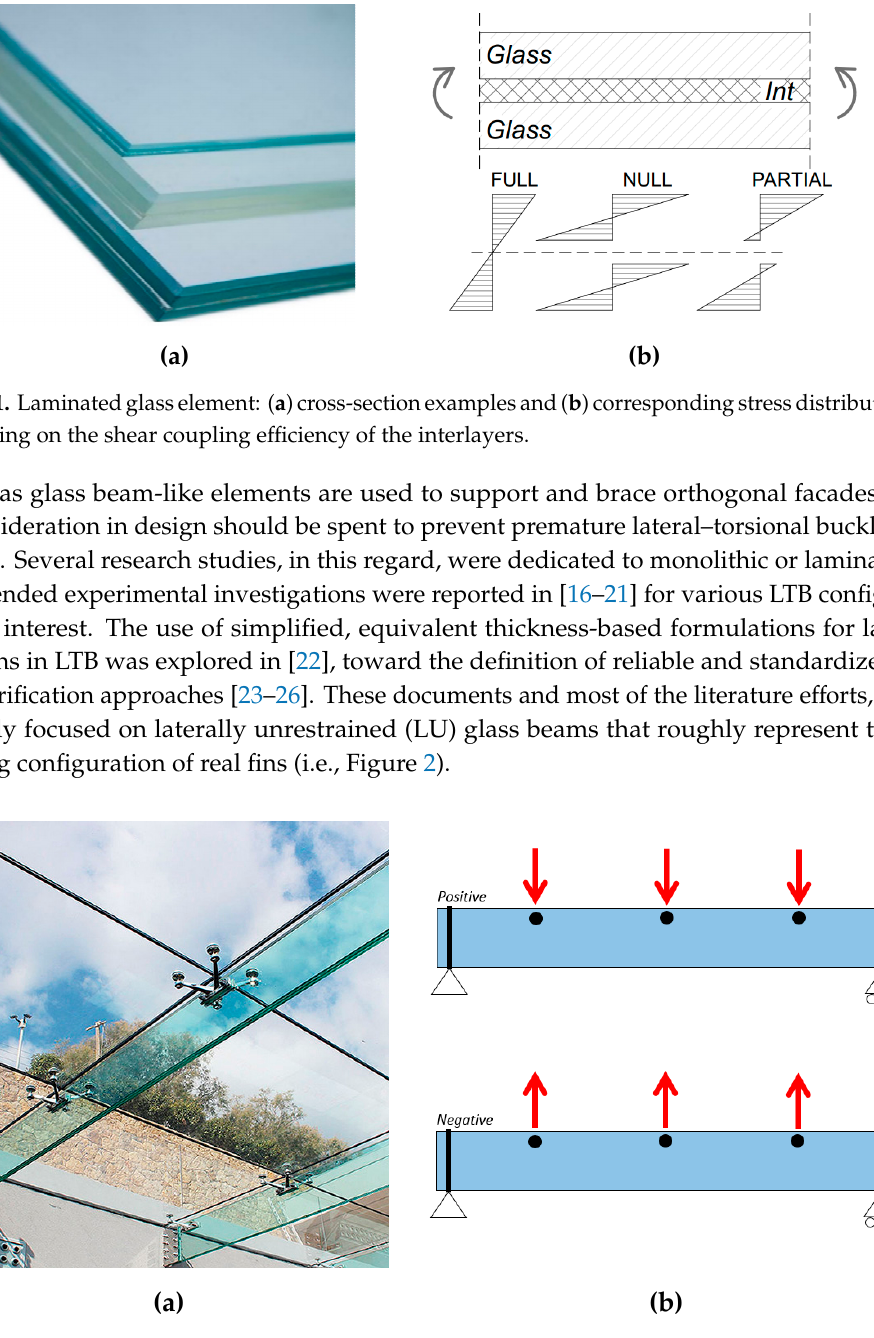
Figure 2. Example of ( a ) laterally restrained (LR) glass beams with discrete mechanical restraints and ( b ) typical loading configurations associated with positive or negative bending effects.